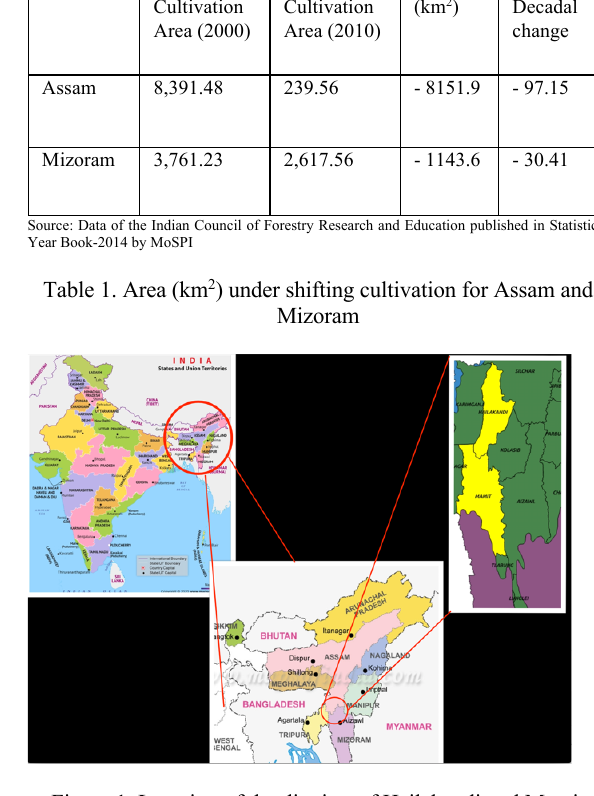
Figure 1. Location of the districts of Hailakandi and Mamit